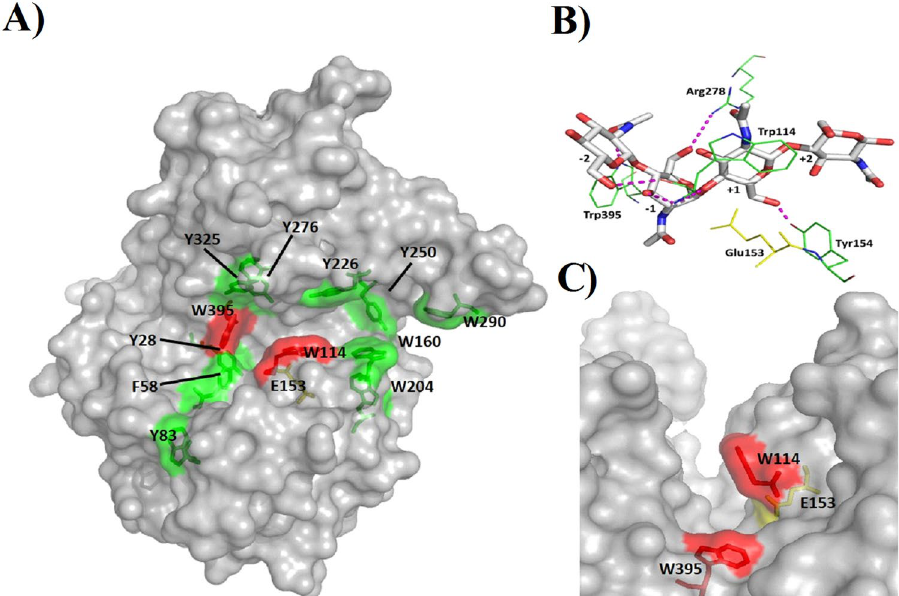
Figure 7. Substrate binding cleft of modelled Ec Chi1. ( A ) Aromatic residues lining along the substrate binding cleft (protein in surface representation and aminoacids in green and red sticks) and aminoacids interacting with chitin tetramer labeled in red colour. ( B ) Docked conformation of chitin tetramer (white sticks) and its possible interactions with residues (green lines) along with catalytic residue, Glu153 (yellow line) of Ec Chi1. ( C ) Deep active site cleft of Ec Chi1 showing catalytic (yellow colour) and aromatic (red colour) amino